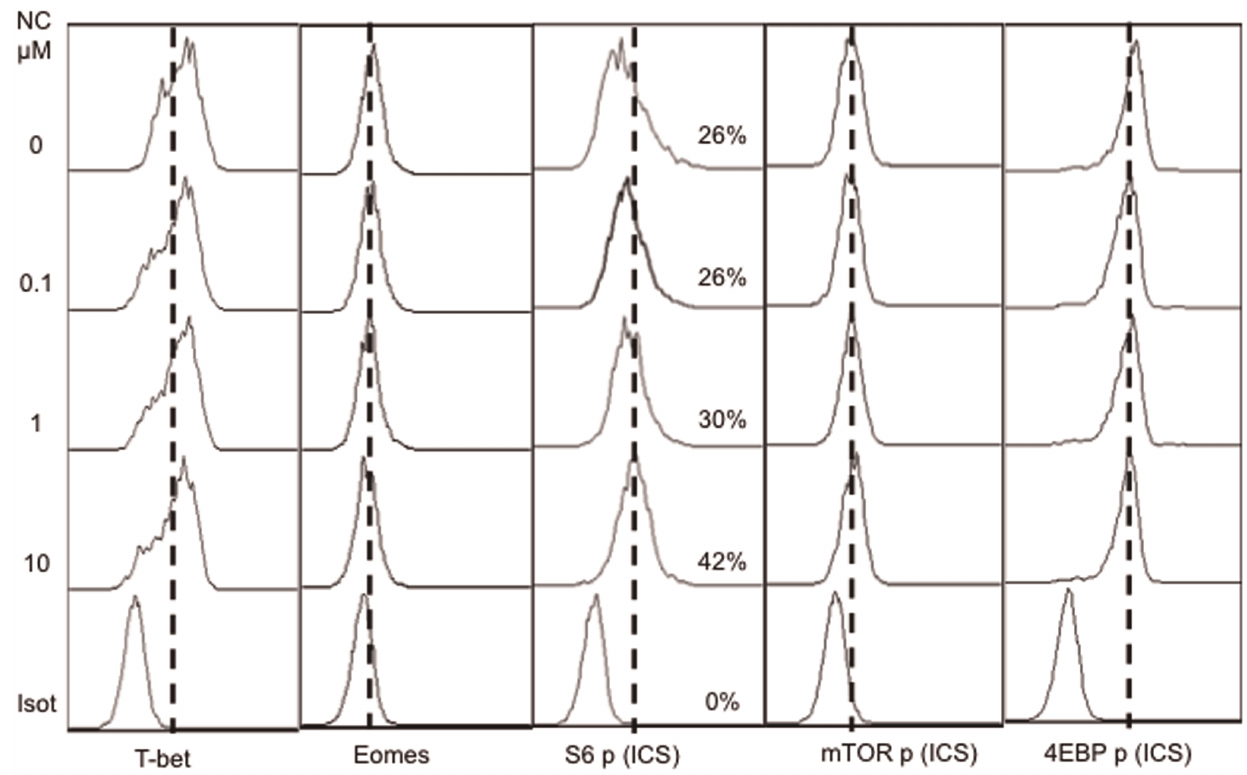
Figure 5. Nicotine effects on T-bet expression and mTOR signaling. Sorted OT-I cells were stimulated with 3SI (antigen + B7 + IL-12) in the presence of nicotine at different concentrations. Programmed CTLs were harvested at 3 days post-stimulation and analyzed for expression of T-bet, Eomes, S6, mTOR nad 4EBP. These are representatives of three independent experiments with similar results.